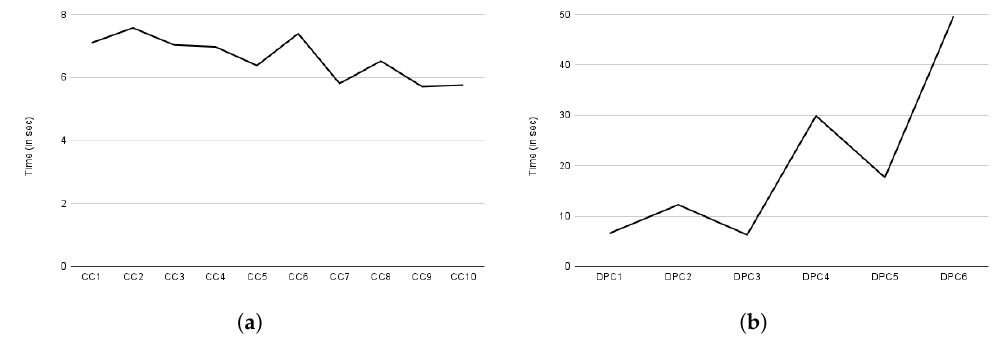
Figure 17. Time spent on compliance checks. ( a ) Execution time for compliance check based on consent. ( b ) Execution time for compliance check based on data provider.